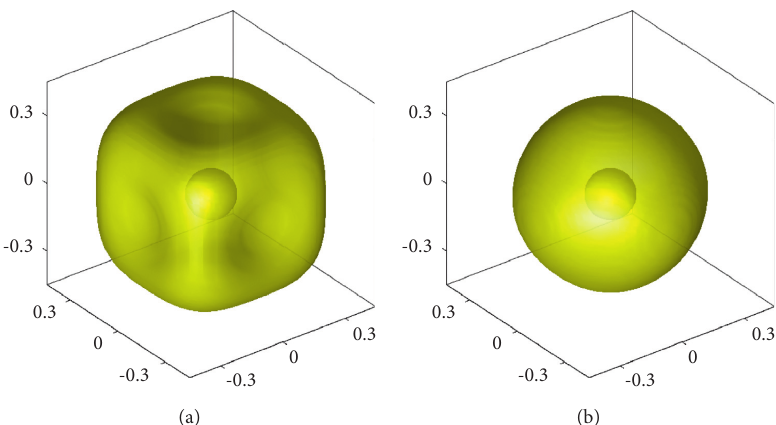
Figure 4: (a) Overlapped isosurfaces ϕ � 0 for evolution in equation (14) with the standard scheme at t � 0 and t � 1600 Δ t . (b) Overlapped isosurfaces ϕ � 0 for evolution in equation (14) with the isotropic scheme at t � 0 and t � 1600 Δ t